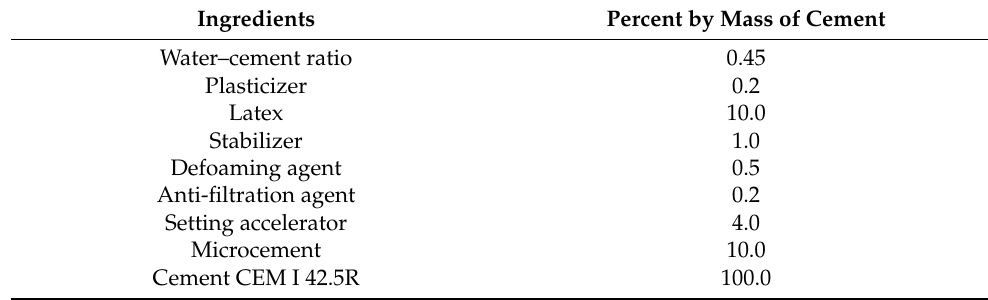
Table 2. Recipe and parameters of the cement slurry used in the adhesion test on the hardened cement–rock contact